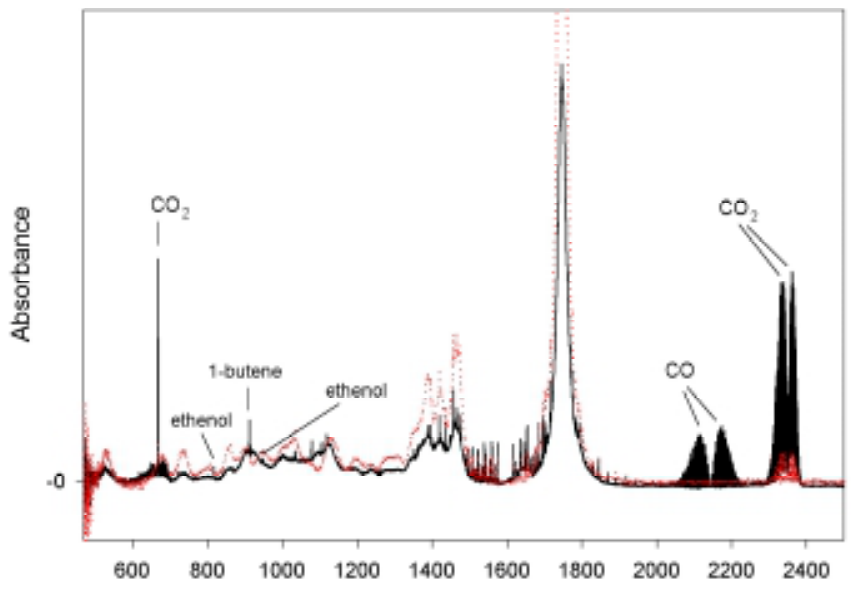
Figure 1. IR spectrum of 100 mTorr n -hexanal, before and after photolysis (6 TL/12 lamps, 100 Torr synthetic air). The differential spectrum is also shown below. Major products CO, 1-butene, and ethanol, and CO as a by-product, are marked (exact positions 2 of the peaks are given in the main